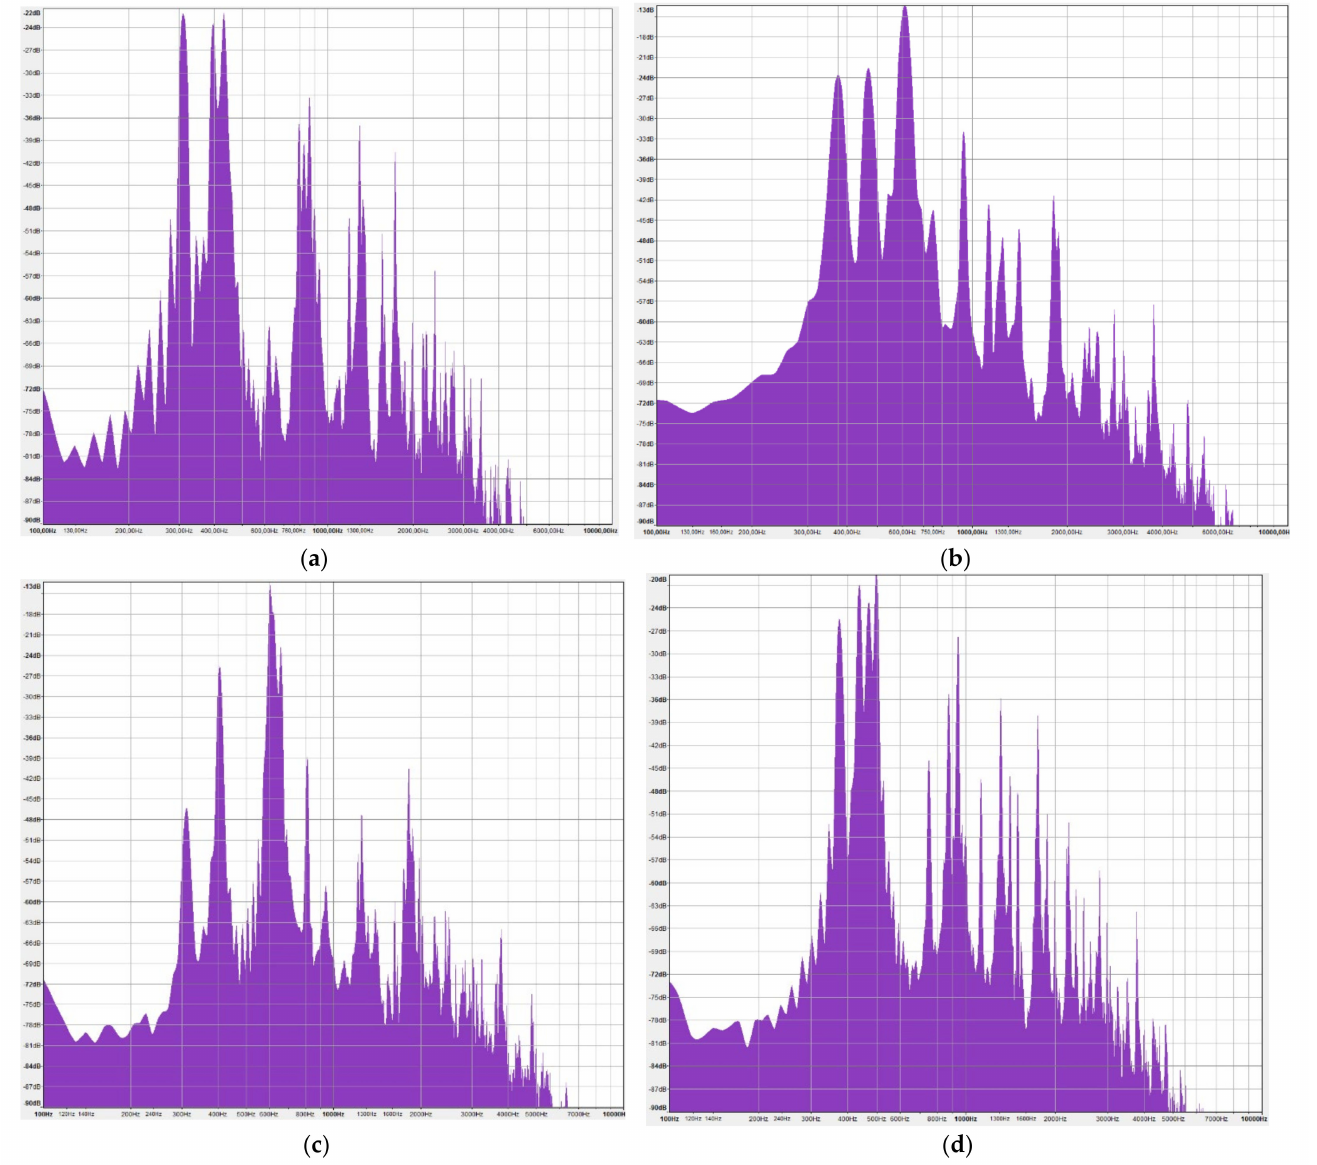
Figure 27. Spectra of quadruple flute experimental model “Anahuacalli 1”, low blowing pressure: ( a ) all fingerholes stopped; ( b ) all fingerholes open; ( c ) fingerholes of pipes A–B open, pipes C–D stopped; ( d ) fingerholes of pipes A–B stopped, pipes C–D open (Sample